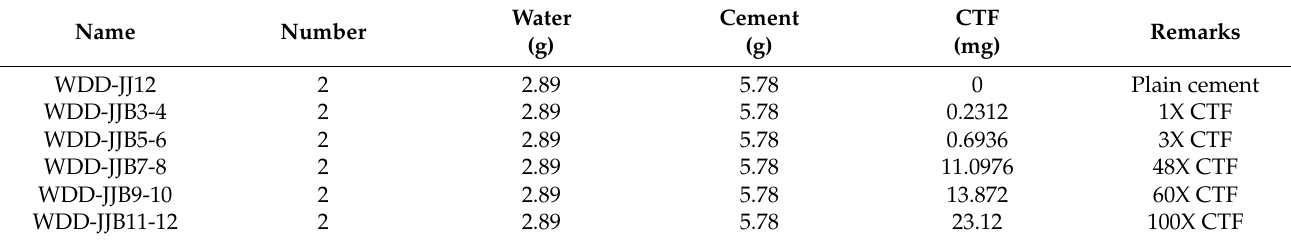
Table 4. Test specimens in cement paste with different content of the CTF.